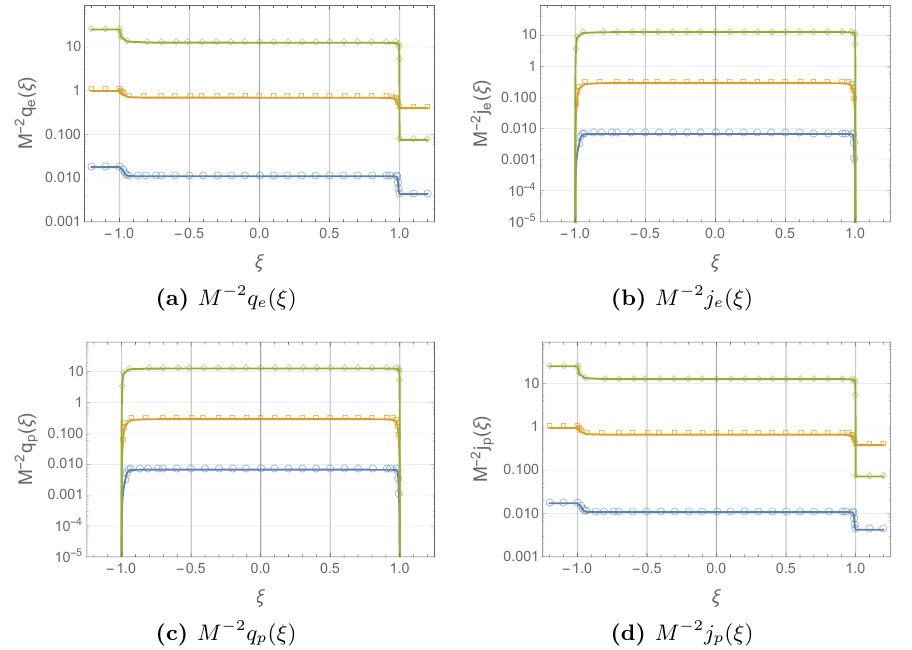
Figure 6. Ray-dependent (a) energy density q e , (b) energy current j e , (c) momentum density q p and (d) momentum current j p in the D 4 (cid:13)ow after bipartite quenches at the Euler scale. The green curve with diamonds corresponds to left and right initial temperatures T l = 7 M and T r = 0 : 4 M , the orange curve with squares to T l = 1 : 4 M and T r = 0 : 9 M and the blue curve with circles to T l = 0 : 2 M and T r = 0 : 1 M . The discrete points in the plots indicated by the plotmarkers are obtained by the numerical solution of GHD equations, the continuous curves are (cid:12)rst order interpolations. Due to relativistic invariance, j e = q p .